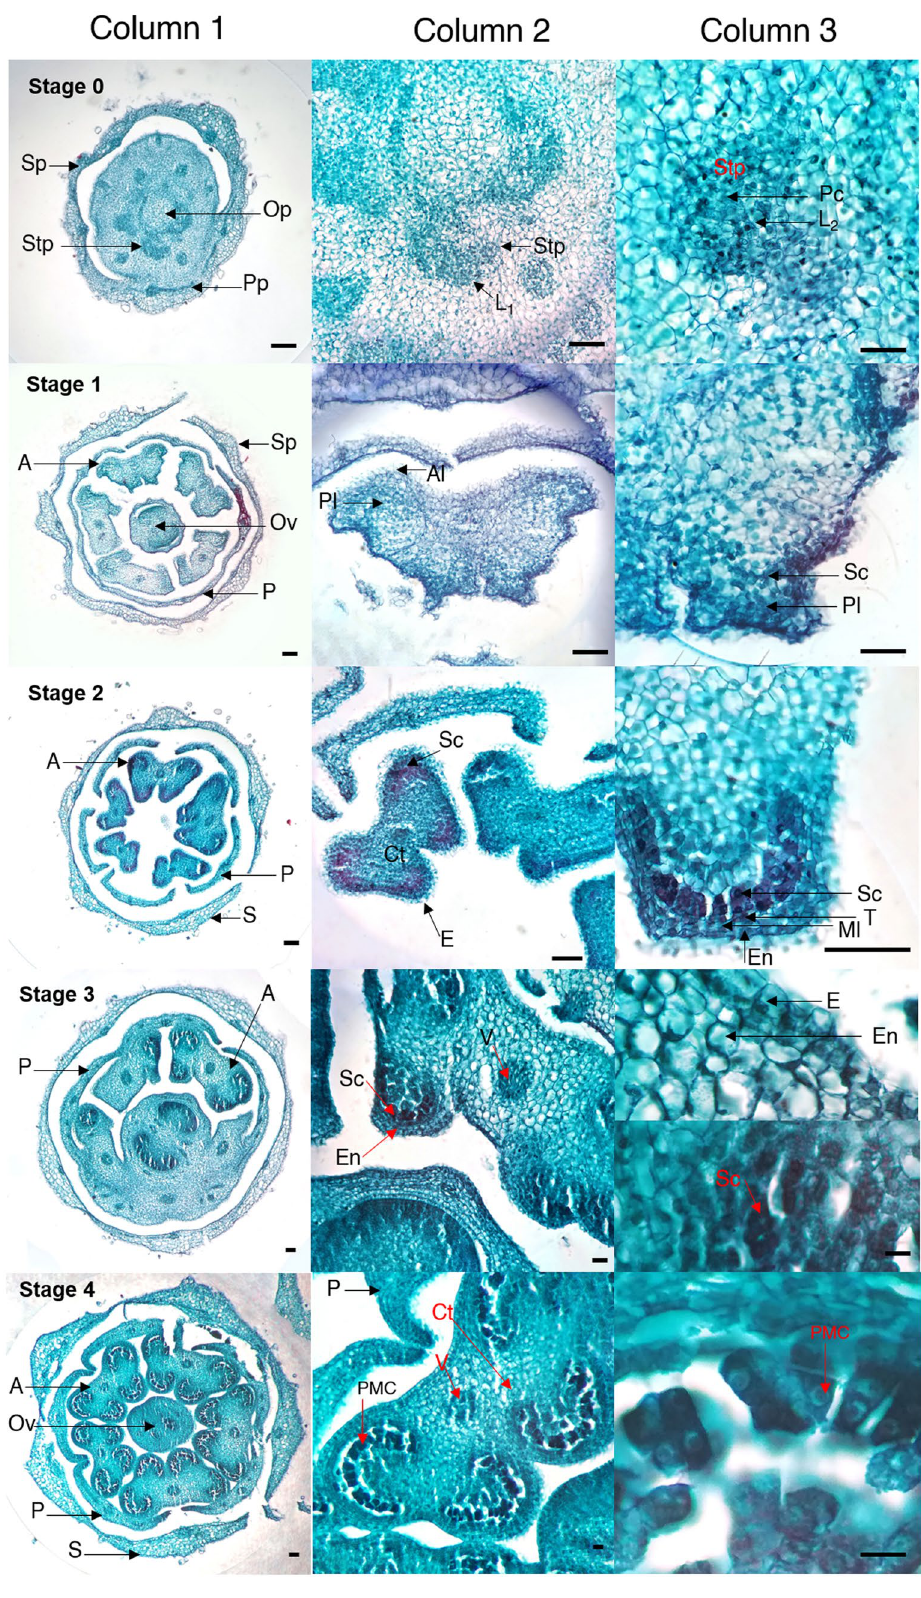
Figure 2. Anther development and pollen formation in diploid yellow potato ( Solanum tuberosum Phureja Group) Criolla Colombia cultivar. Stages of development: 0–4. A Anther, Al anther lobe, Ct connective tissue, E epidermis, En endothecium, L1, L2 lines of primordia of the stamen, Ml midline, Ov ovary, Op ovary primordia, P petal, Pc procambial cells, Pl parietal line, PMC pollen mother cell, Pp petal primordia, Sc sporangial cells, Sp sepal primordia, S sepal, Stp stamen primordia, T tapetum, V vascular tissue. Scale bars, 100 µm (column 1); 50 µm (column 2); 25 µm (column 3). Image created by the